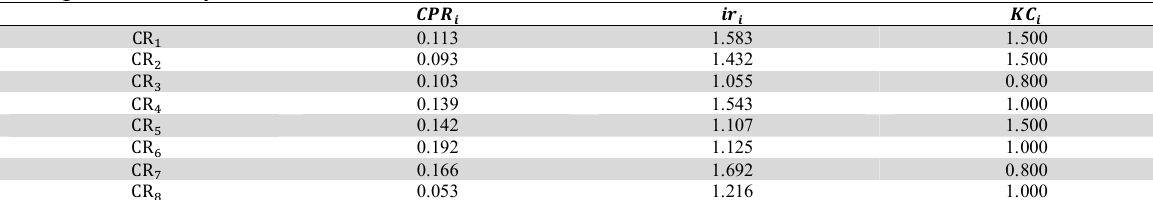
Competitive analysis results of the